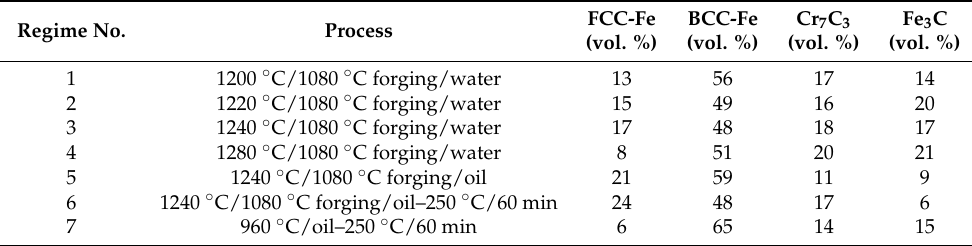
Table 4. Phase fractions determined by X-ray diffraction analysis after various experimental regimes. Regime No.